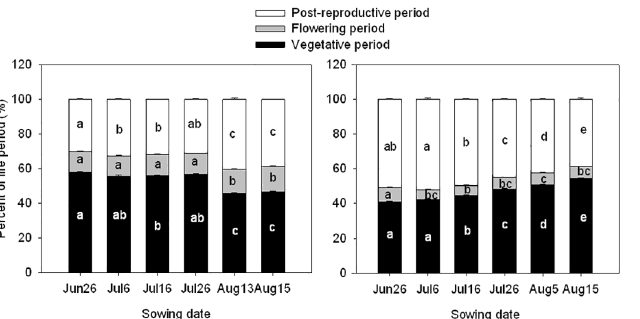
Fig 1. Differences in percent of life period occurring in the vegetative, flowering, and post-reproductive stages of development for Chenopodium glaucum (left panel) and Amaranthus retroflexus (right panel) as influenced by sowing date. Error bars are ± SE. Different letters for the same period of development indicate differences using Tukey ’ s multiple comparison test with a significance level of